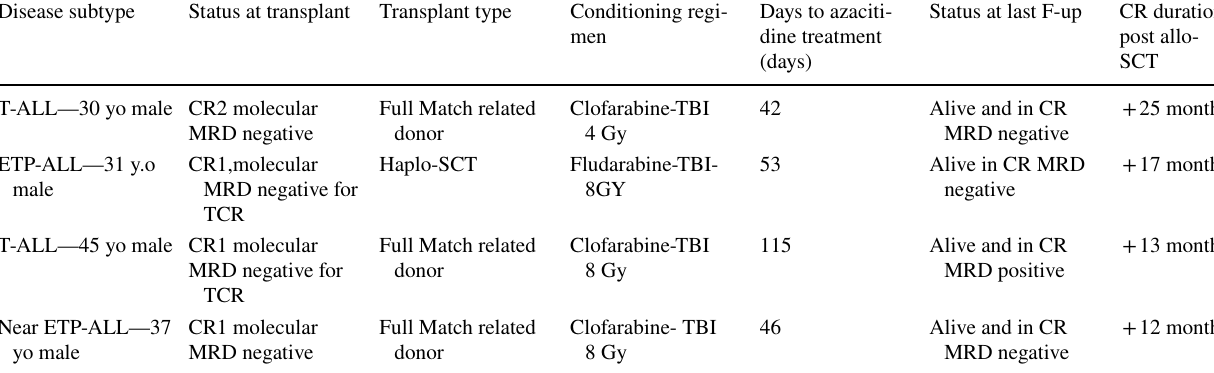
Table 1 Summary for the four patients who received 5-azacitidine and venetoclax maintenance